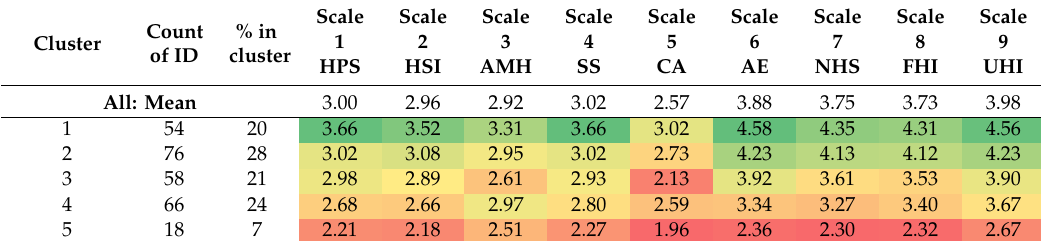
Table 2. Cluster